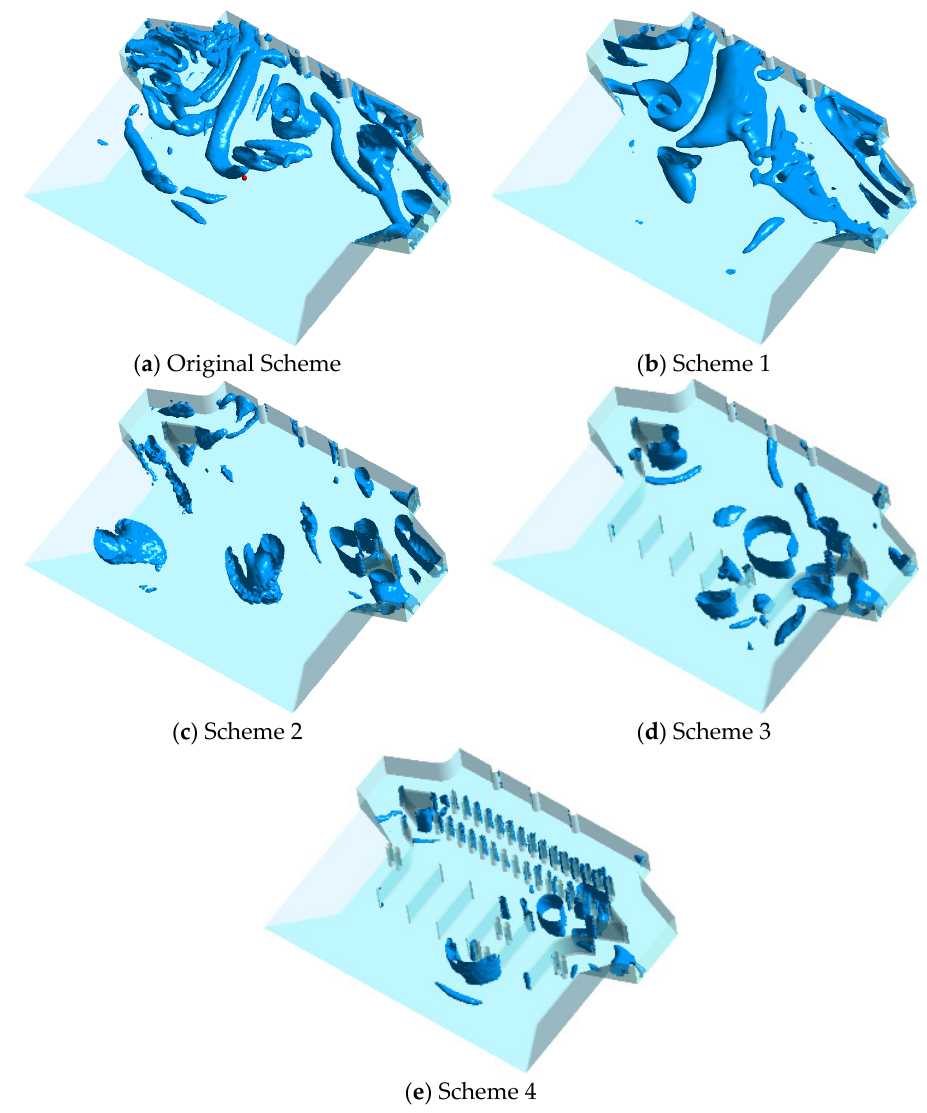
Figure 10. Vortex distribution in